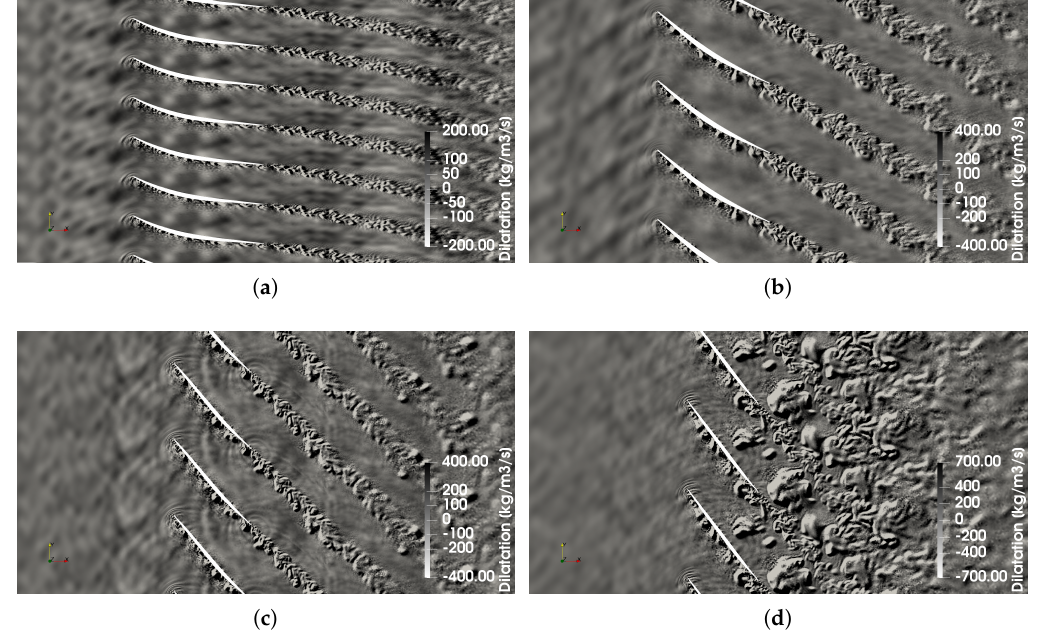
Figure 11. Dilatation ( ∂ρ / ∂ t ) contours in the rotor-locked reference frame at different spanwise positions: ( a ) 25%; ( b ) 50%; ( c ) 75%; ( d )